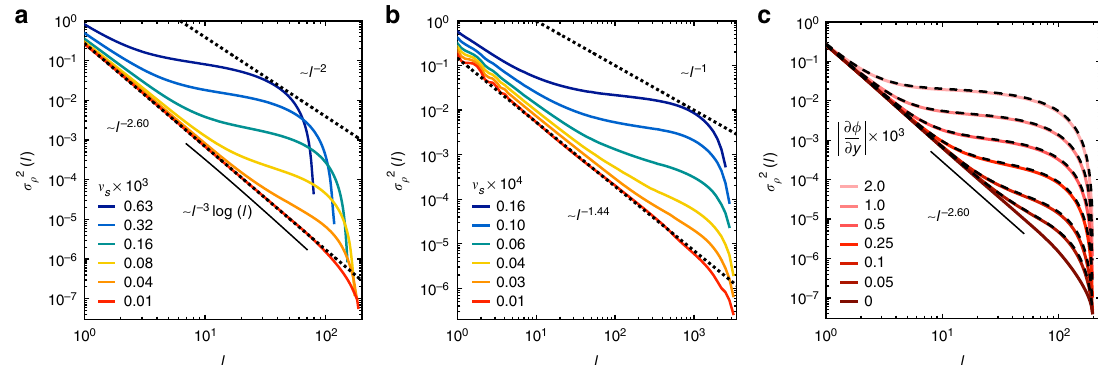
Fig. 4 Number density fl uctuations. a Steady state variance of the number density, σ 2 ρ ð ‘ Þ , versus window size, ‘ , in 2D simulations with sedimentation and shear. Each point is an average of 50 measurements with N = 9677, γ = 3.0, and κ = 48.4. At low sedimentation speed, hyperuniform density fl uctuations are observed, as shown by the dotted line following 0 : 27 ‘ (cid:4) 2 : 60 . An uncorrelated system would scale as ‘ (cid:4) 2 . b Analogous results in 1D simulations, averaged over 20 systems with N = 3000 and γ = 1. At low sedimentation speed, hyperuniform density fl uctuations are observed over 3 decades in ‘ , following 0 : 15 ‘ (cid:4) 1 : 44 . An uncorrelated system would scale as ‘ (cid:4) 1 . c Variance of the number density for initially hyperuniform 2D systems that were scaled along the y axis to impose a constant concentration gradient, ∂ ϕ = ∂ y j j . Each curve is an average over 31 systems with N = 10,186, γ = 3.0, L = 200, and ϕ = 0.2. The variance increases with the size of the gradient. The data are captured by summing the measurement at zero gradient with a term due to a uniform gradient that we calculate in the continuum limit (dashed lines: Eq. (4), using Eq. (5) with the value of ∂ ϕ = ∂ y critical height of the bed of particles, h c , we obtain: